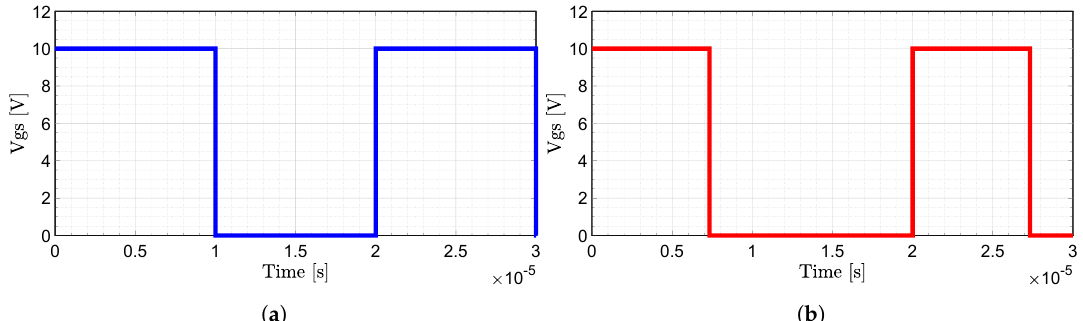
Figure 7. ( a ) Gate to source voltage of the forward converter; ( b ) gate to source voltage of the buck converter.